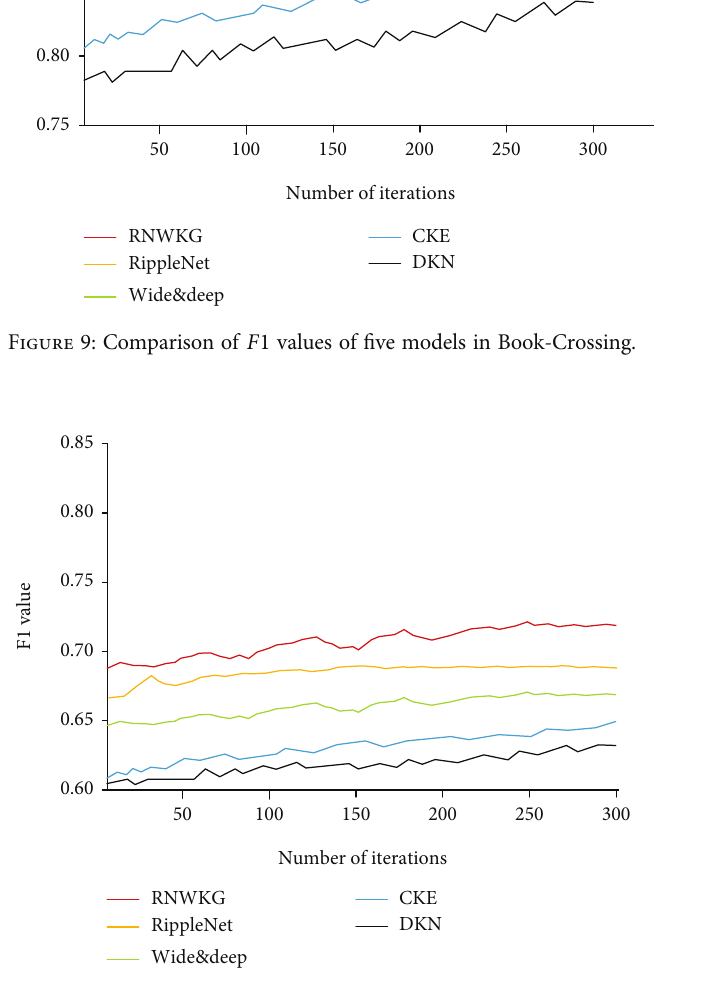
Figure 10: Comparison of F 1 values of fi ve models in